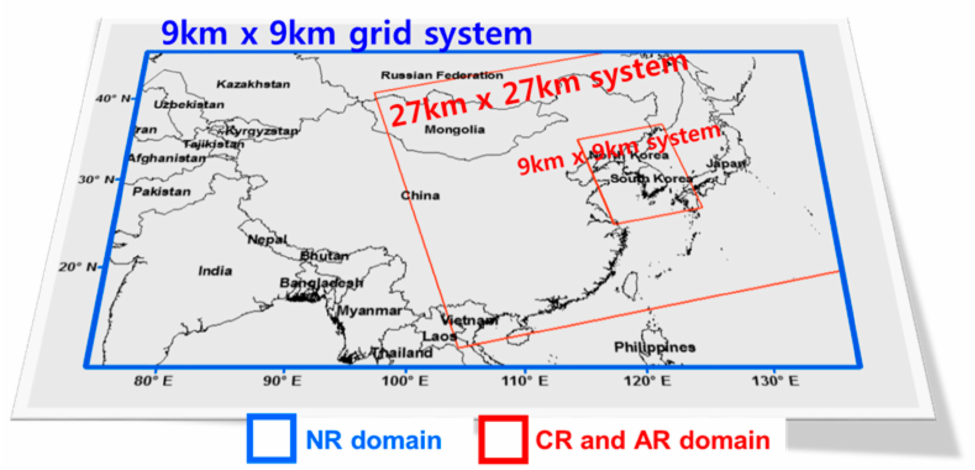
Figure 2. The Observing System Simulation Experiments (OSSE) testbed domain. The NR boundary in blue shows the domain for the nature run; the CR and AR boundaries in red indicate the domain for control and assimilation runs,